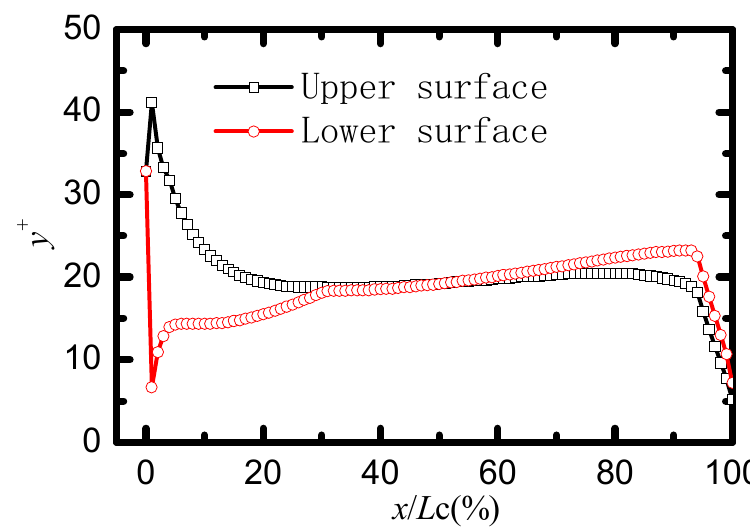
Figure 4. y + distribution along the upper surface and lower surface of the hydrofoil.